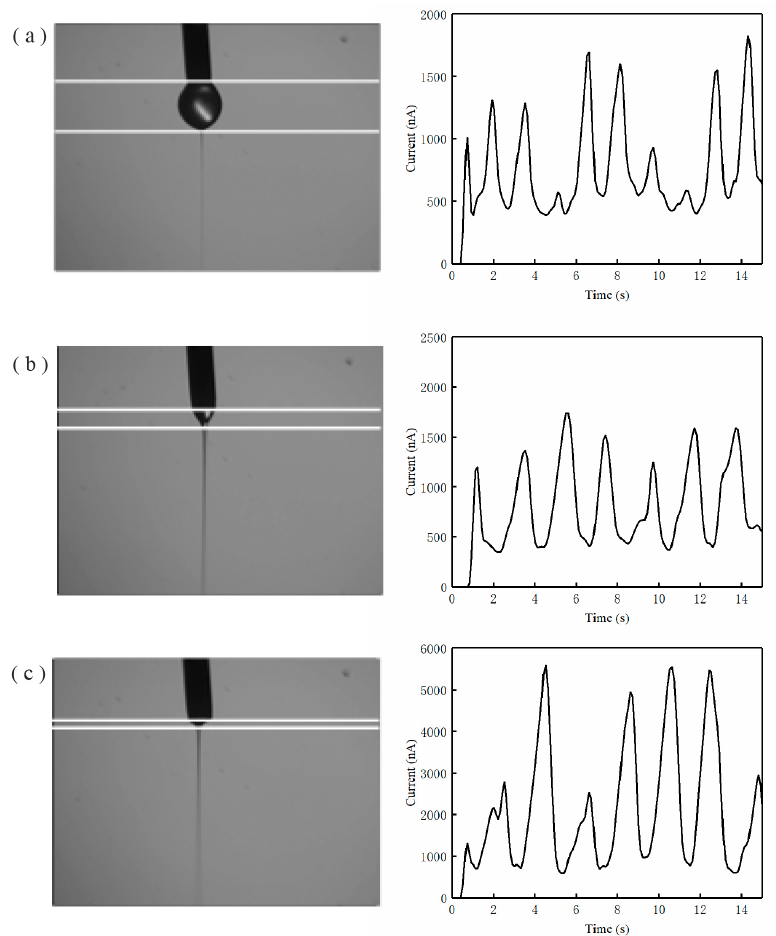
Figure 4. Jet mode recognition with current waveform: ( a ) droplet ejection mode; ( b ) Taylor cone ejection mode; ( c ) retractive ejection mode.